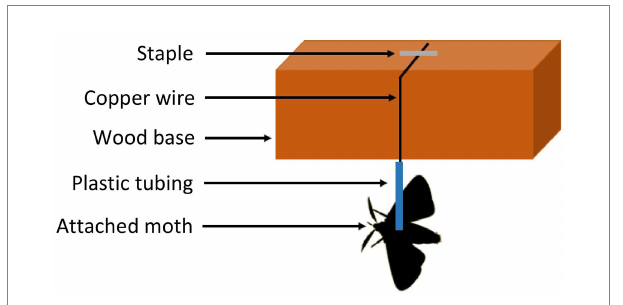
FIGURE 1 Set up used for forced flight experiments of tethered true armyworm moths. A video is provided as Supplementary Video